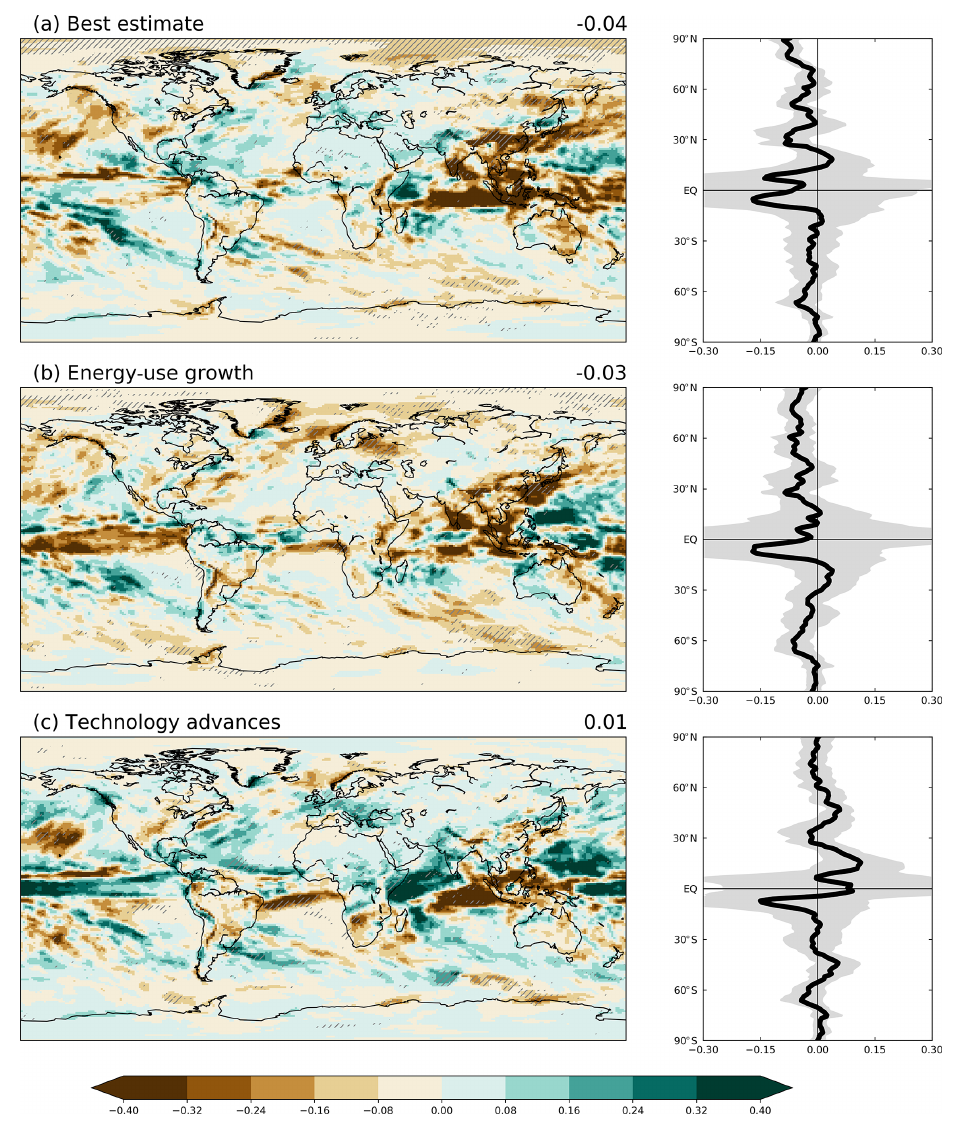
Figure 6. The same as Fig. 4 but for precipitation response ( (cid:49) mmd − 1